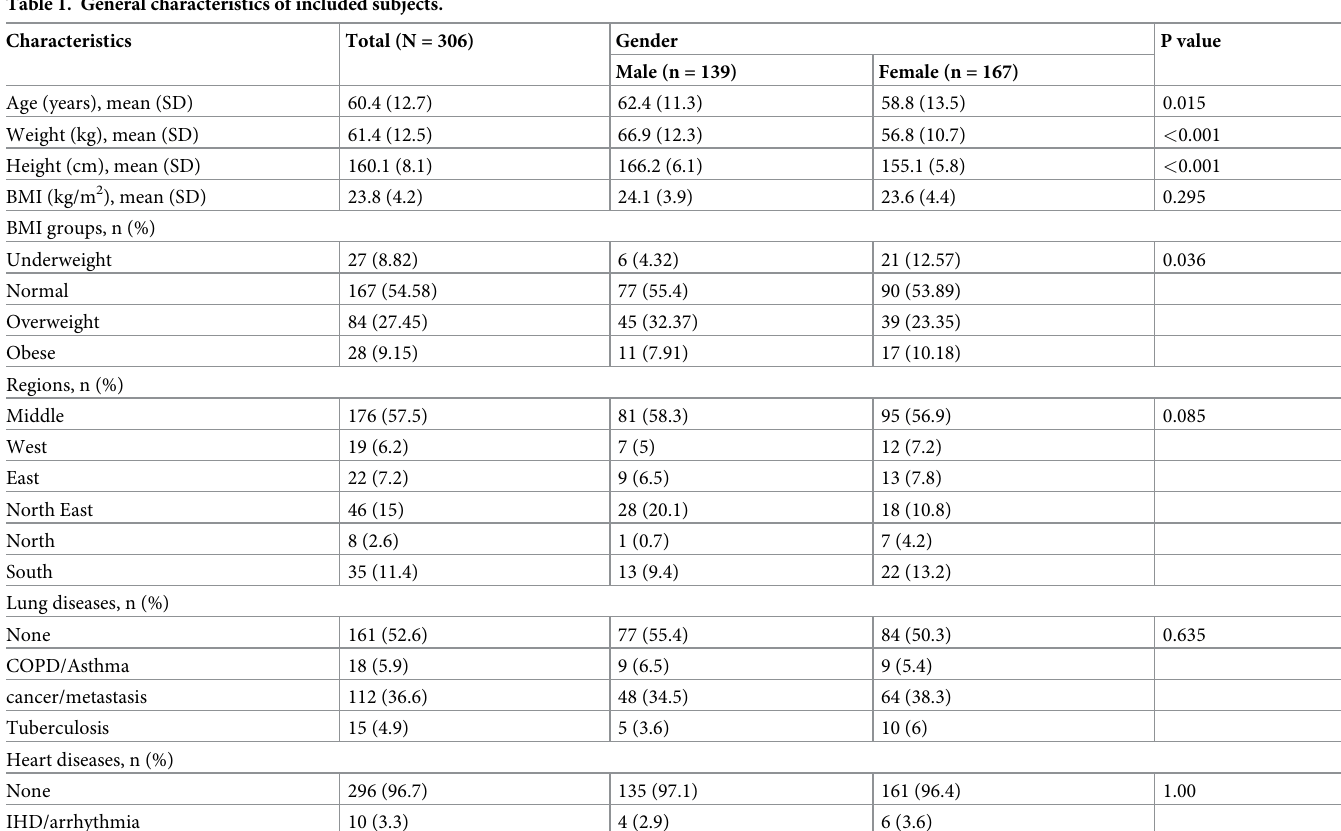
Table 1. General characteristics of included subjects.